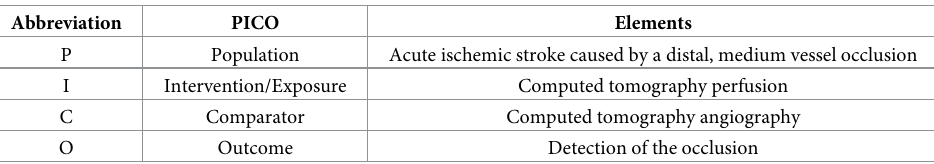
Table 2. PICO description.